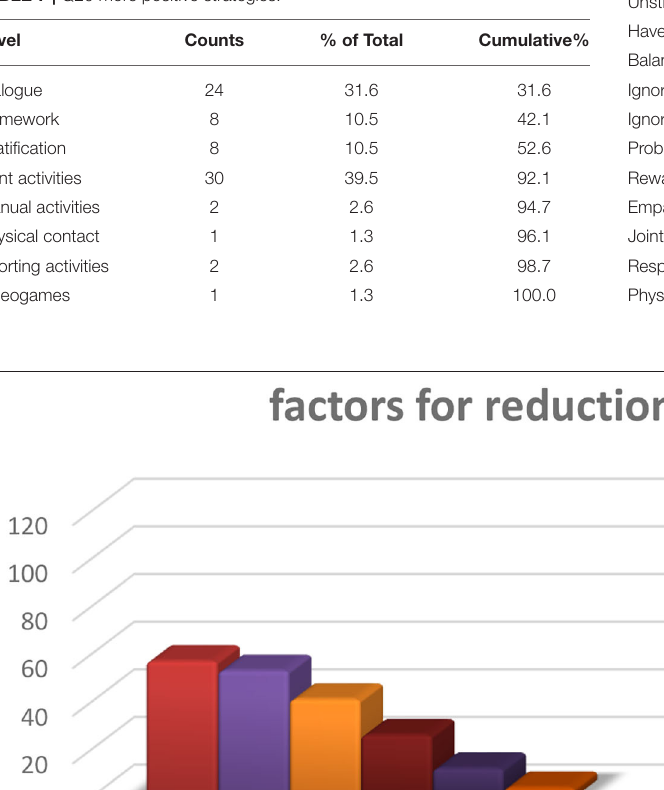
TABLE 7 | Q20 more positive strategies.